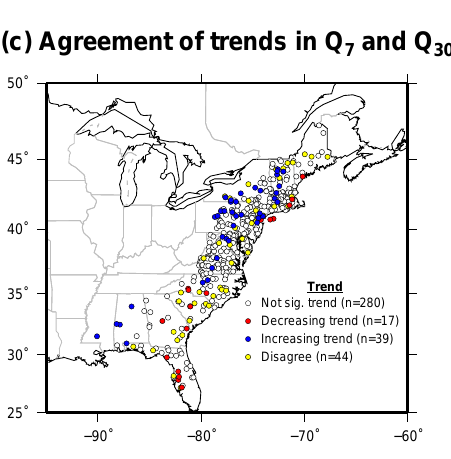
Figure 6. Trends in (a) Q7 and (b) Q30 for 1951–2005 and (c) their